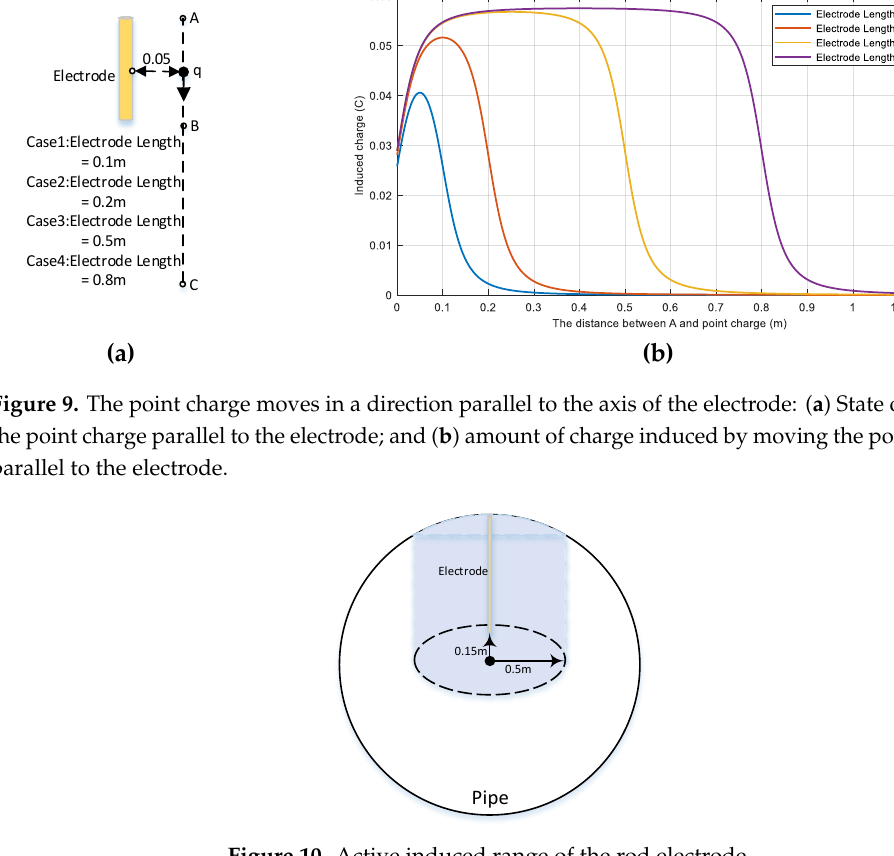
Figure 10. Active induced range of the rod electrode.